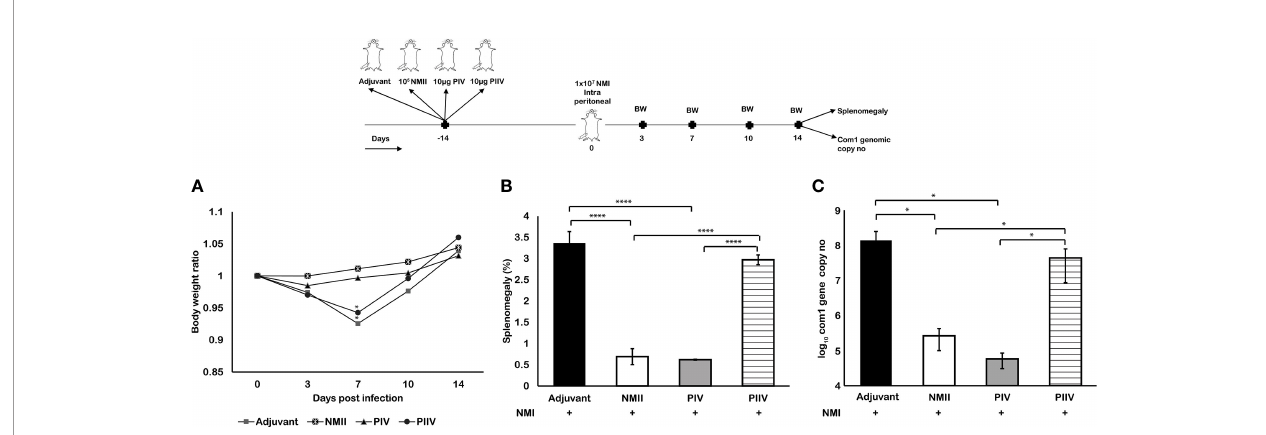
FIGURE 6 | Mouse immunization with viable NMII bacteria provides similar protection as formalin-killed PIV. BALB/c mice were IP vaccinated with 1 × 10 5 GE of viable NMII, SQ immunized with 10 µg of PIV, or SQ immunized with 10 µg of PIIV and IP challenged with 1 × 10 7 GE of NMI at 14 dpv. Body weight ratio (A) , splenomegaly ( B , % of spleen weight/body weight), and bacterial burden (log 10 C. burnetii com1 gene copy numbers) in the spleen (C) were evaluated at 14 dpi. Each experimental group includes four mice, with error bars representing the standard deviations from the means. *p < 0.05; ****p < 0.0001, as determined by Welch t test using GraphPad.